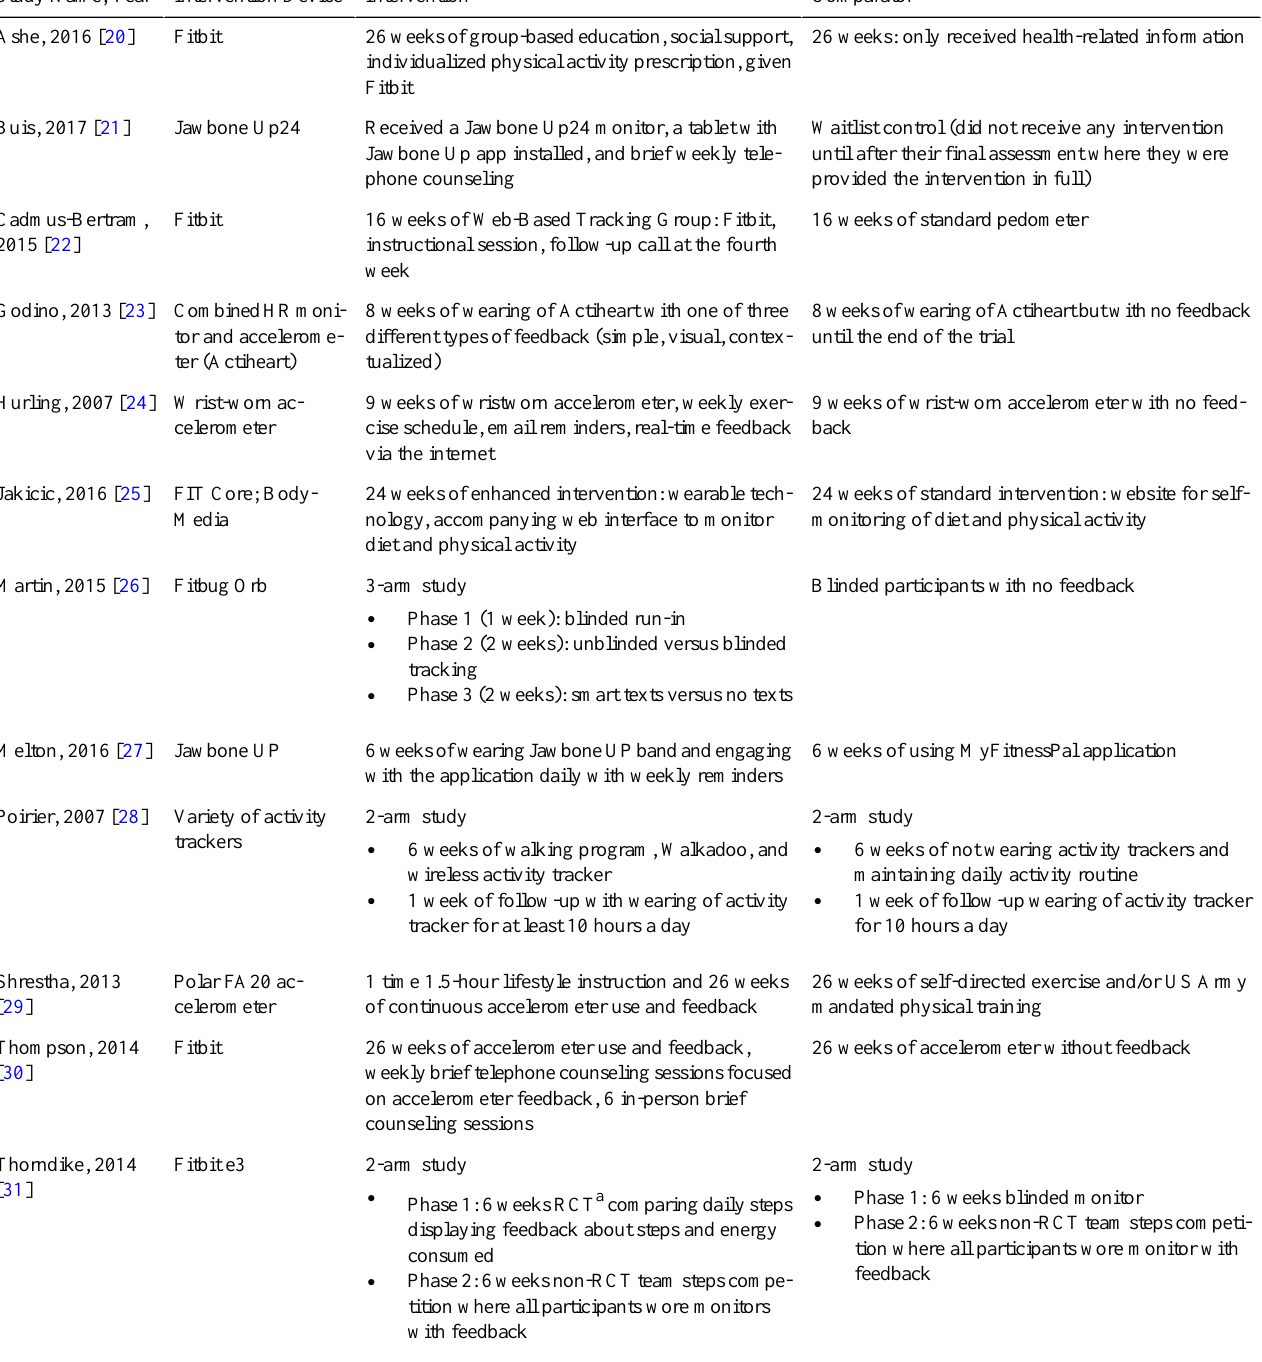
Table 2. Characteristics of intervention and comparators of included studies. ComparatorInterventionIntervention DeviceStudy Name, Year